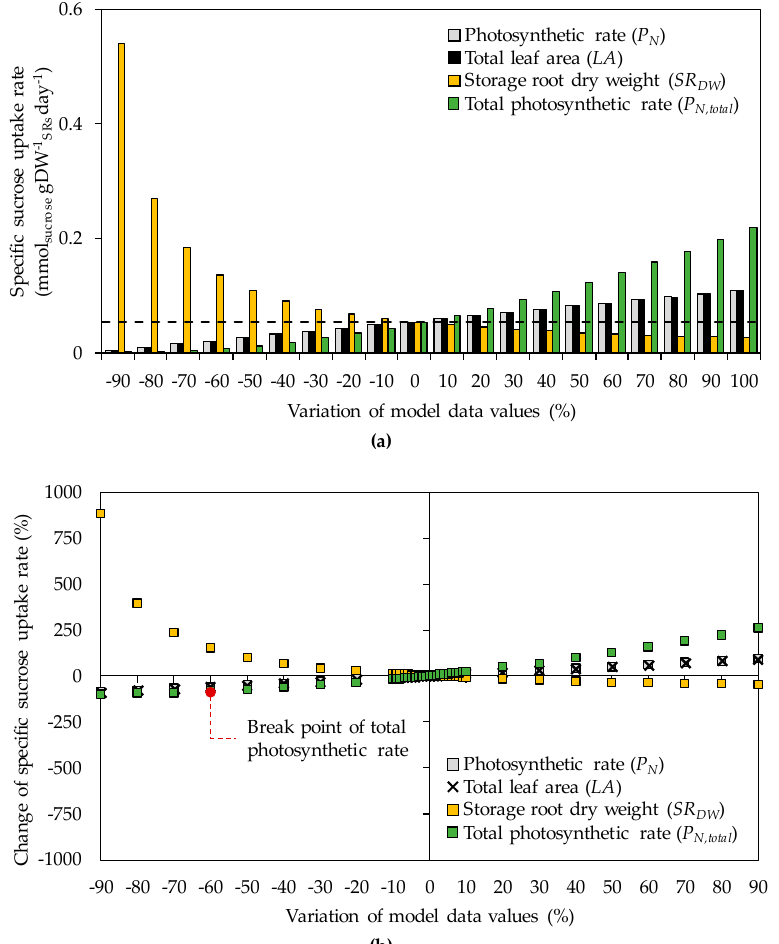
Figure 2. Model sensitivity to changes in the photosynthetic rate, total leaf area, storage root dry weight, and total photosynthetic rate, regarding ( a ) specific sucrose uptake rate and ( b ) percent variation in the specific sucrose uptake rate compared to the original value. The black dashed line denotes the original value of the specific sucrose uptake rate. The red circle denotes the breakpoint, where the predicted carbon flux direction and partitioning differed from the original values in the rMeCBM-KU50 model.